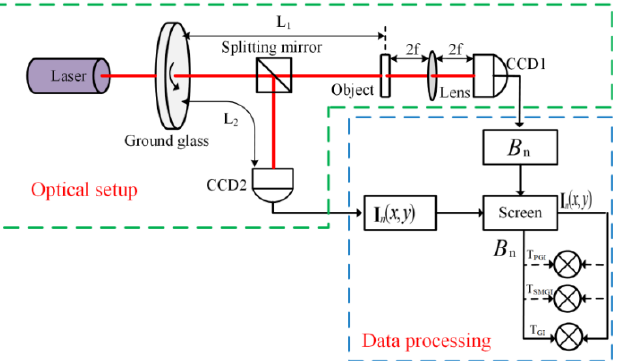
Figure 1. The schematic diagram of the experimental setup and data processing. L1 is the distance between the rotating ground glass and the measured object, L2 is the distance between the rotating ground glass and the charge coupled device 2 (CCD2) (L1 = L2). f is the focal length of the lens.